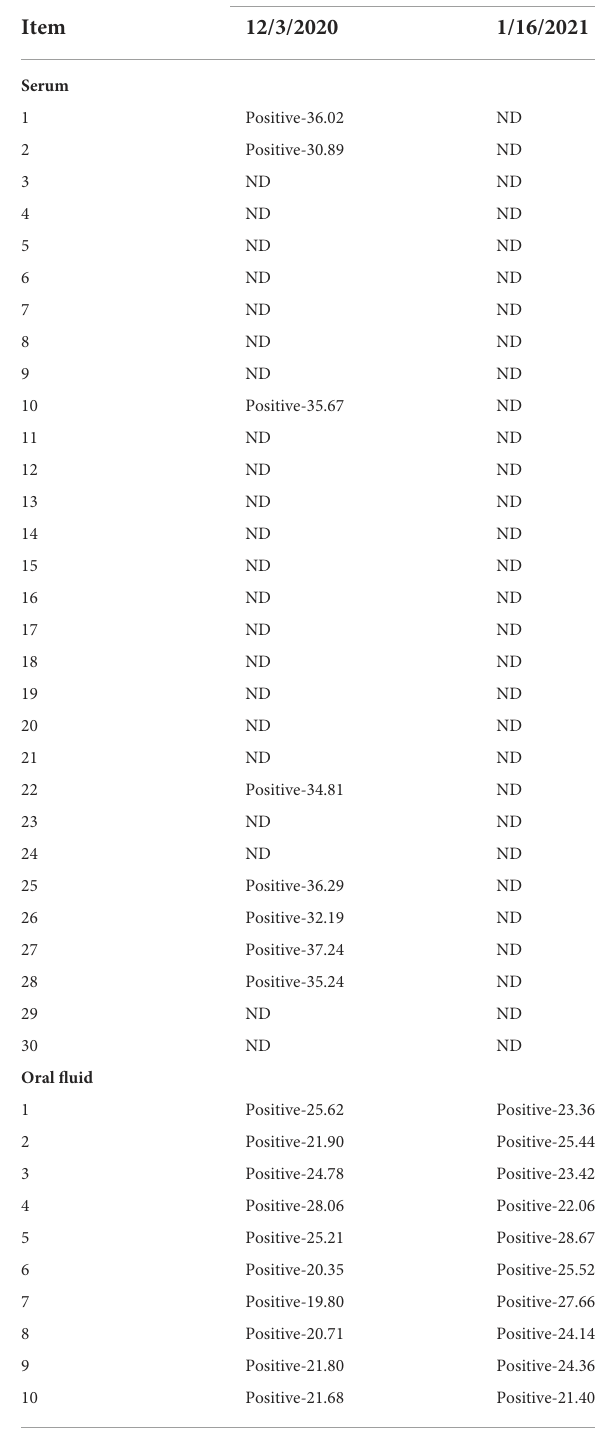
TABLE 2 Detectable atypical porcine pestivirus (APPV) RNAemia status TABLE 3 Detectable atypical porcine pestivirus (APPV) RNA for 30 for 4 pens in an isolation nursery barn on two separate sampling dates. individual pig serum on different sampling Sampling day